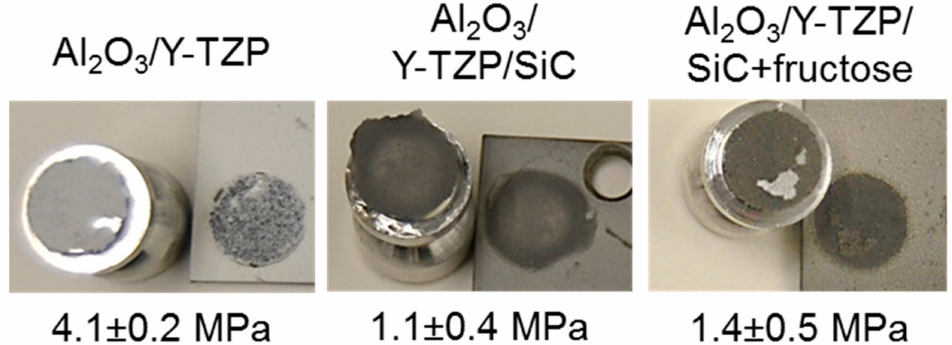
Figure 8. Tested samples by pull-off and their adherence values.